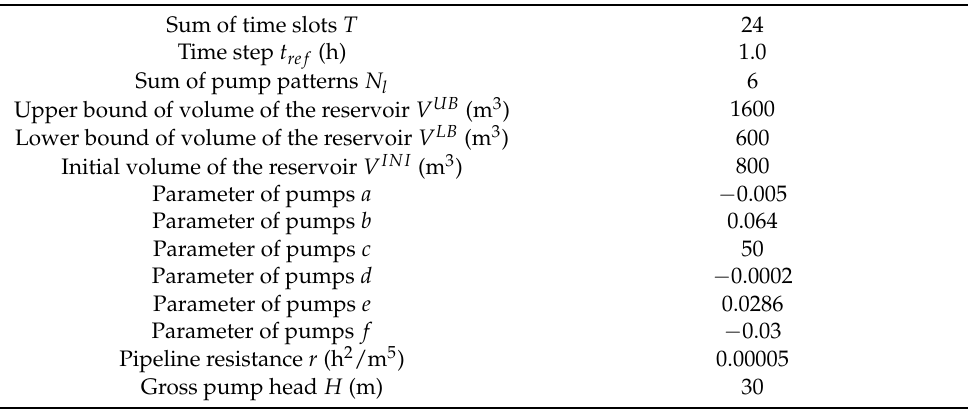
Table 1. Parameters of the numerical experiment.